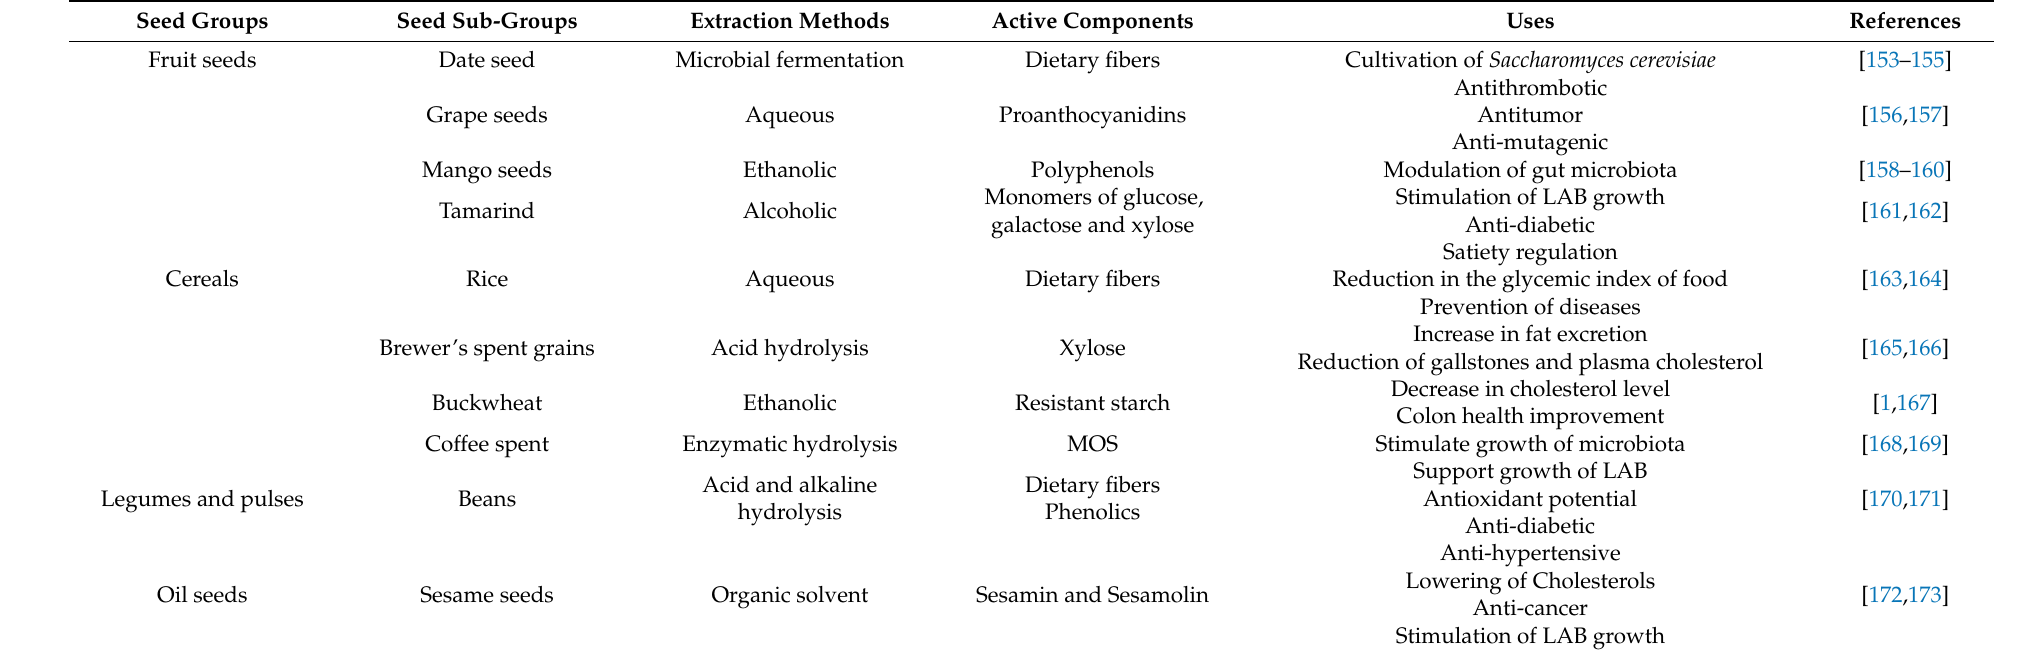
Table 4. Potential applications of seed wastes as